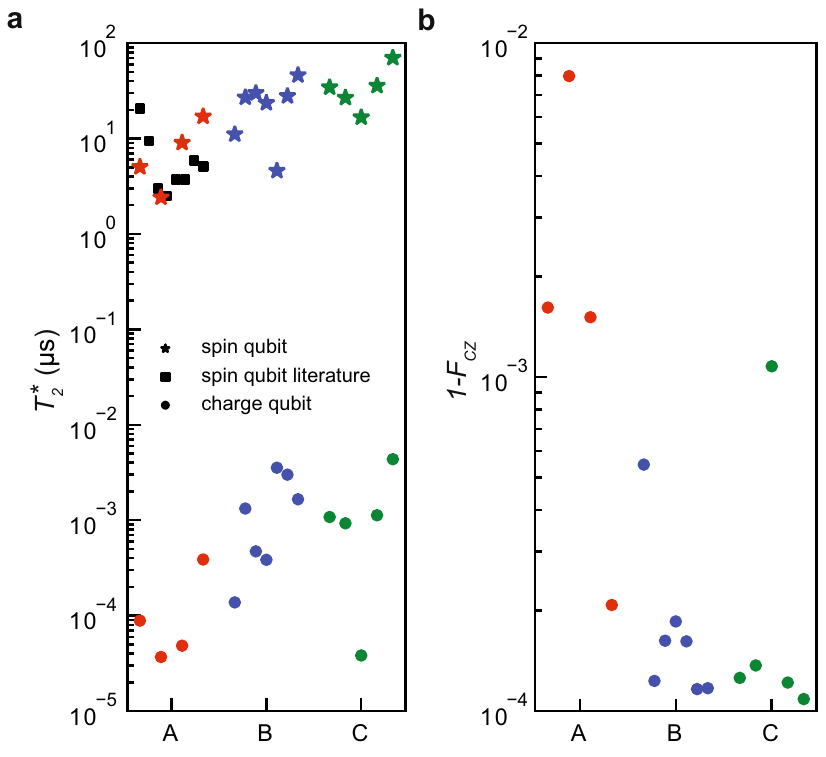
Fig. 4 | Calculated dephasing times and in fi delity. a Computed dephasing times T ? 2 of a charge qubit (circle) and of a spin-qubit (star) using S ϵ , min from hetero- structureA(red),B(blue),C(green).Eq.(1)wasusedtocompute T ? 2 asafunctionof S ϵ and α from Fig. 3 with frequency cutoffs ( f min , f max )=(1.6mHz,33GHz) and